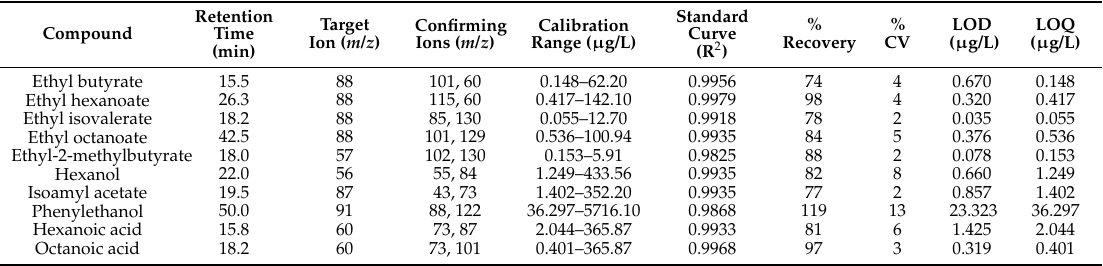
Table 3. Volatile aroma compounds, retention times, target and confirming ions, calibration ranges, standard curves, % recovery, % coefficient of variation (CV), limits of detection (LODs) and limits of quantitation (LOQs). LODs were calculated as the mean of the blank plus 3* standard deviation for each analyte in a blank sample. LOQs were calculated as the mean of the blank plus 10* standard deviation for each analyte in a blank